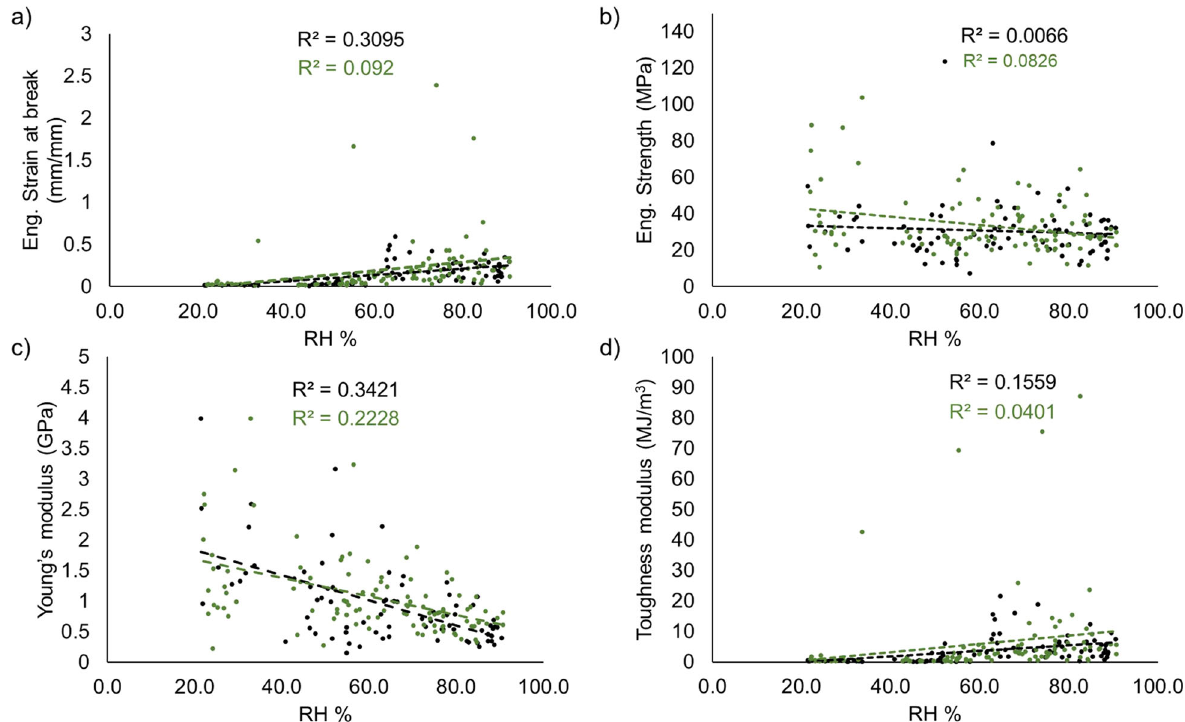
Fig. 4 Fiber mechanical properties at different relative humidity (RH). a Eng. Strain at break of the fi bers tested at different equilibrium states of relative humidity (RH). b Eng. Strength. c Young ’ s modulus. d Toughness modulus. The color green is used for the NT2Rep Y-F CT and the color black for the